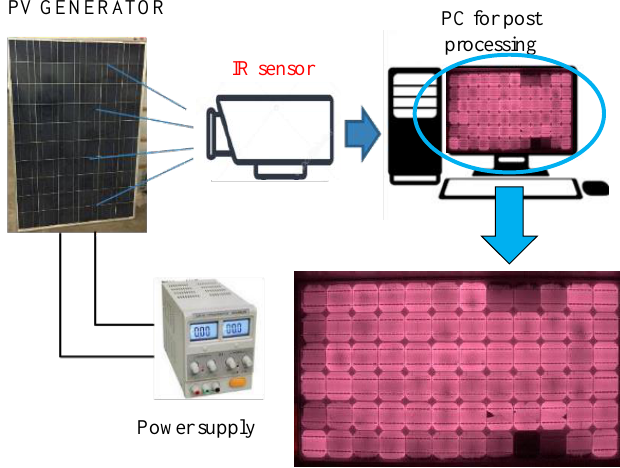
Figure 2. Scheme for the electroluminescence (EL) test of a PV module.